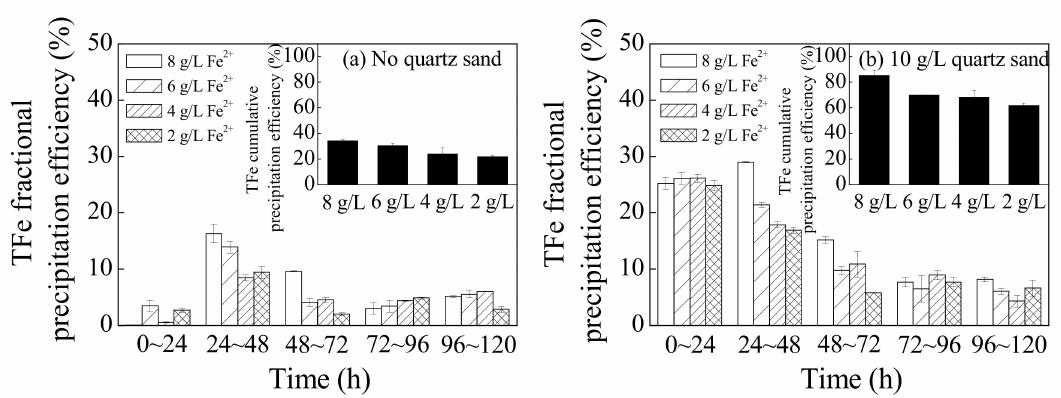
Figure 4. The changes in total Fe (TFe) precipitation efficiency in the municipal sewage sludge leachate with different treatments at 28 ◦ C and 180 rpm for 120 h: ( a ) no quartz sand; ( b ) 10 g · L − 1 quartz sand (initial pH = 2.55, Fe 2+ concentration = 2–8 g · L − 1 , sludge leachate volume = 270 mL, A. ferrooxidans LX5 volume = 30 mL, A. ferrooxidans LX5 density = 5 × 10 7 cells · mL − 1